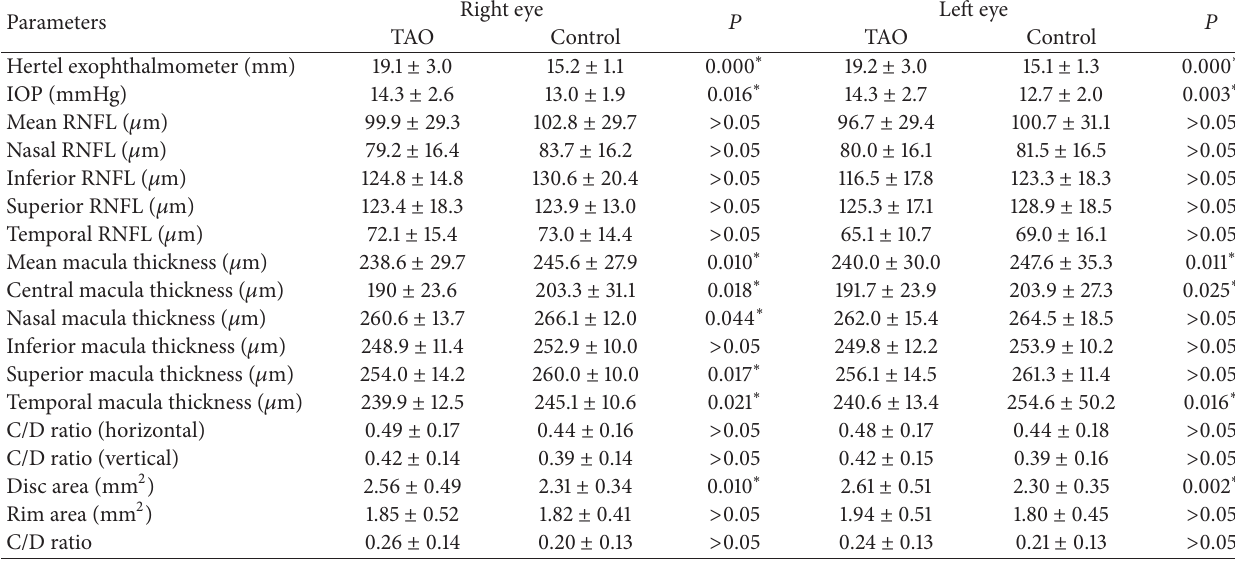
Table 1: Comparison of the parameters between the patients with thyroid-associated ophthalmopathy (TAO) and control group according to side of the eyes.